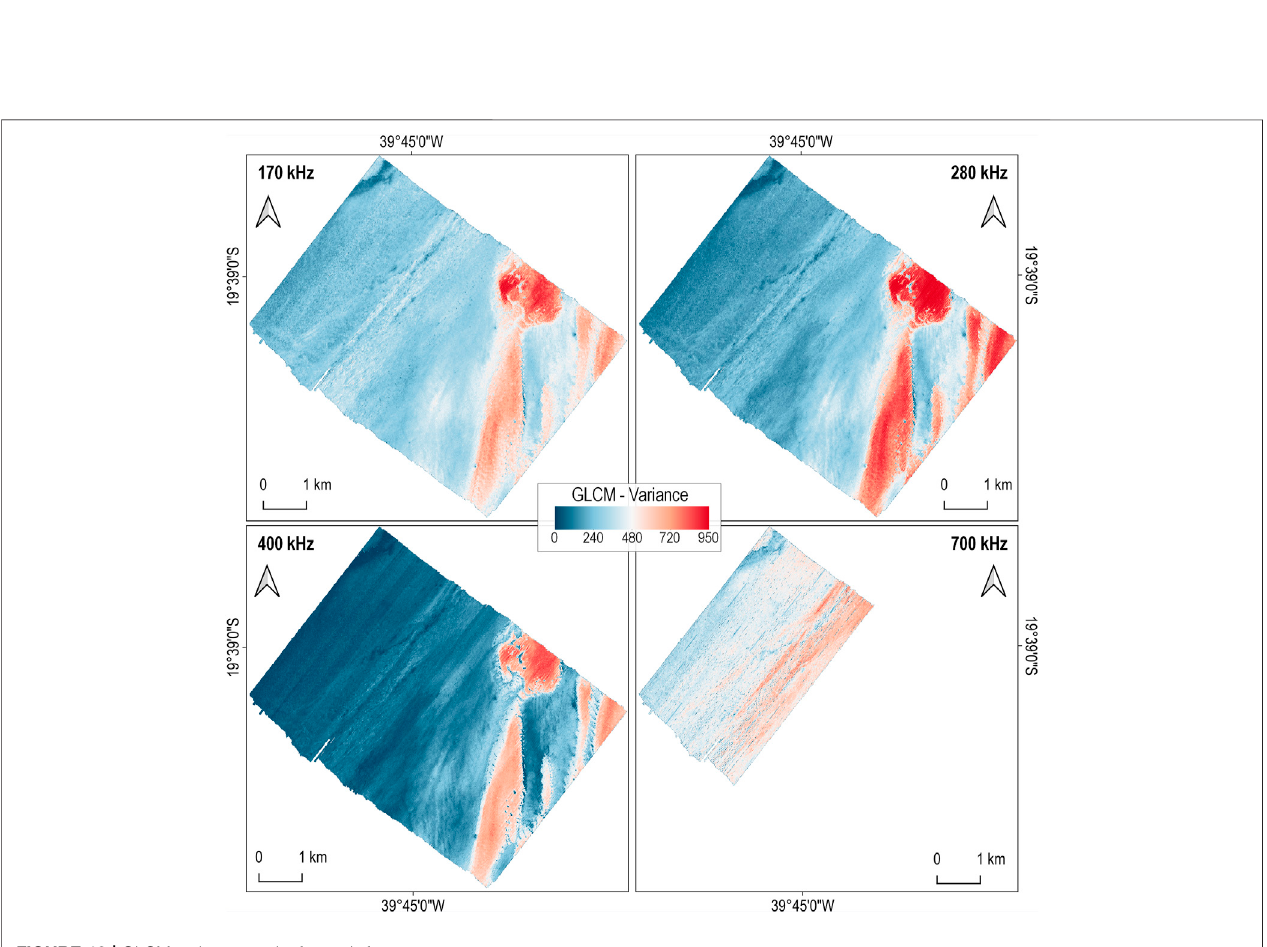
Frontiers in Remote Sensing |